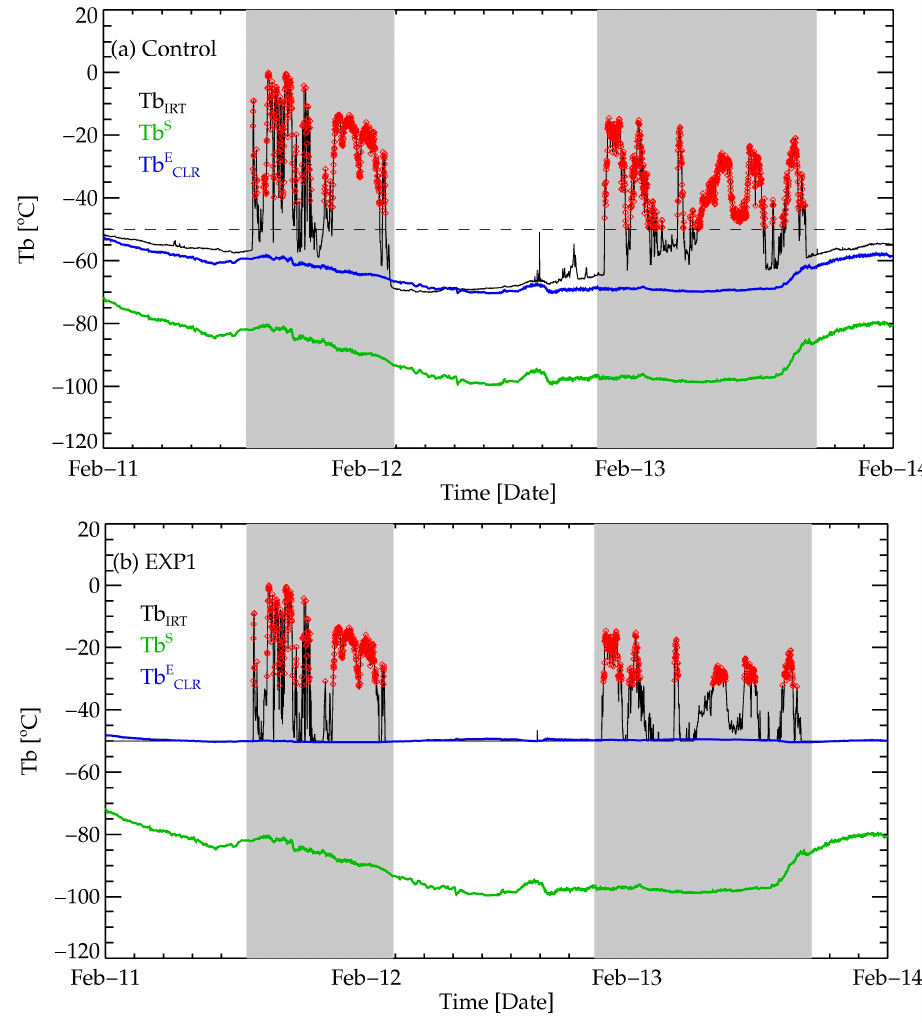
Figure 4. Time series of the brightness temperatures (Tbs) (the Tb IRT (black), Tb S (green), Tb ECLR (blue)) for each experimental dataset (( a ) Control and ( b ) EXP1) for three days in February 2015. Here, the red diamonds are the cloudy data detected by the spectral test.